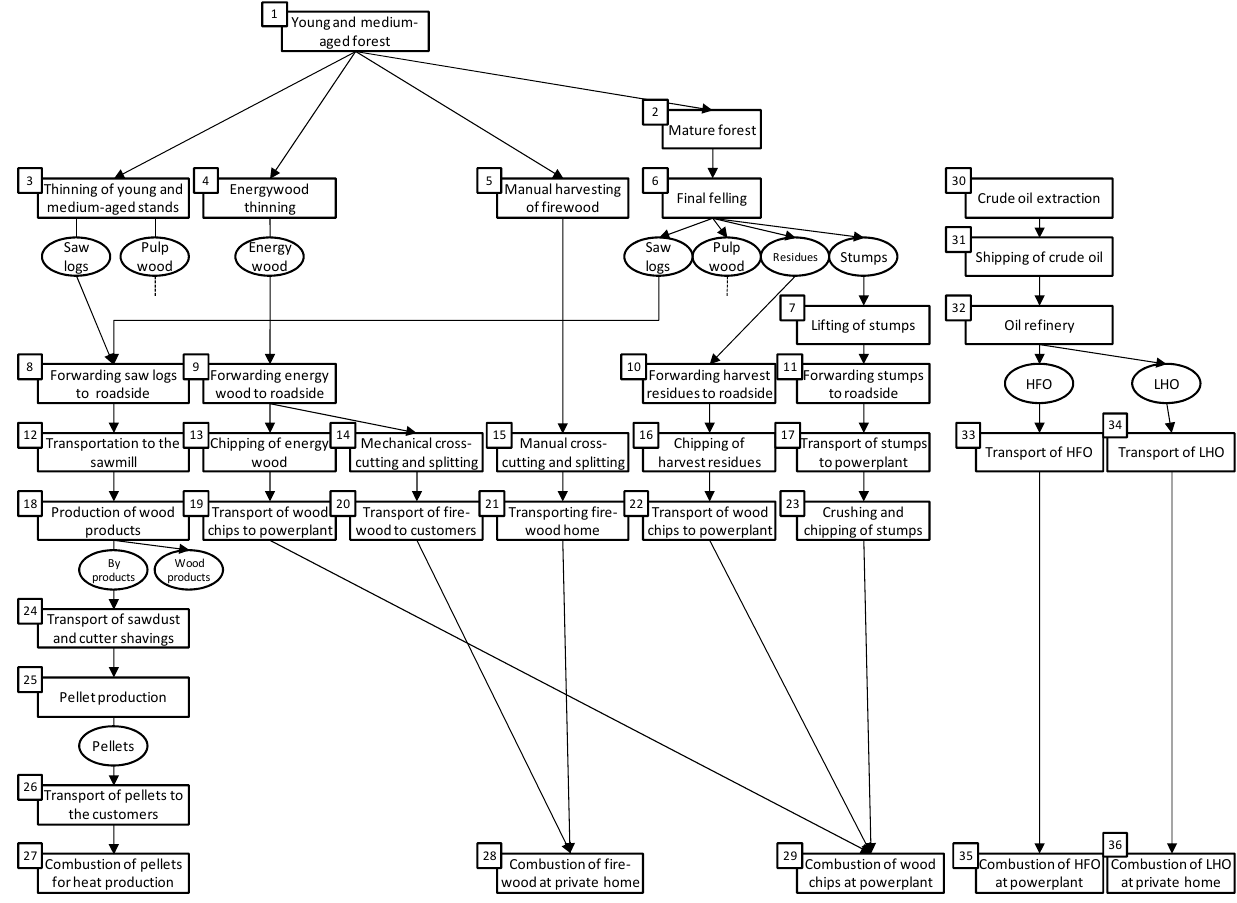
Figure 1. Topologies of the pellet, firewood, wood chip from energy wood, harvest residues and stumps and the heavy fuel oil (HFO) and light heating oil (LHO) production chains. Processes are represented by rectangle shapes. The products (oval shapes) pulpwood and wood products leave the chain. Please note that some processes are identical in several production chains. For instance, the process crude oil extraction belongs to the heavy fuel oil and the light heating oil production chain. The processes of the production chain are numbered and refer to the assumptions which are described in more detail in Table